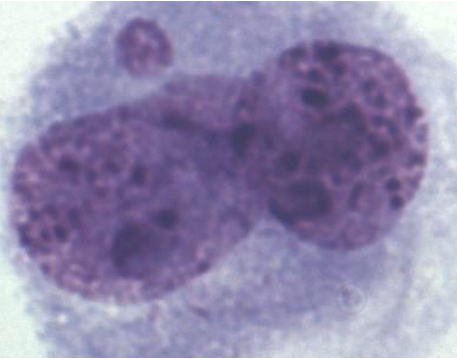
Figure 2. Binucleated cell (BNC) with one micronucleus (BNC + MN) in interspecific hybrids; Giemsa